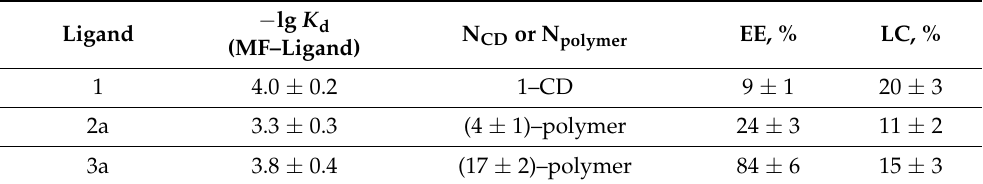
Table 3. Dissociation constants of MF conjugate complexes determined by FTIR spectroscopy. Number of MF molecules held by one conjugate molecule in CD tori (N CD ) and polymer matrix